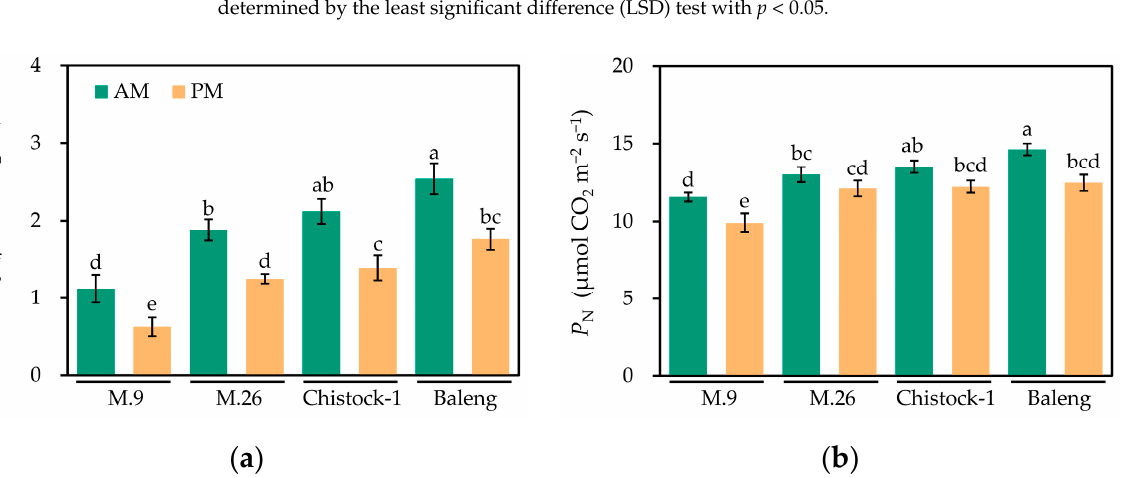
SPAD was measured on the same functional leaves. Data in the table are mean values ( n = 3–4) ± standard error (SE). Different letters after mean values ± standard error in the same column indicate the significant difference determined by the least significant difference (LSD) test with p < 0.05.